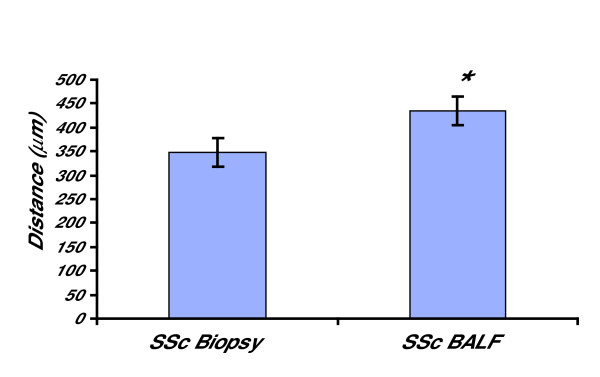
Migration of fibroblasts from BALF and bronchial biopsies from patients with SSc. Fibroblasts were cultured from BALF and bronchial biopsies in a "clone-cylinder", which was removed after 24 h. The distance from the border of the removed cylinder covered by the cells was measured after an additional 48 h. Values are presented as means ± SEM for n = 5 patients/group. *Significant difference when comparing the migration between BALF fibroblasts and biopsy fibroblasts from patients with SSc.